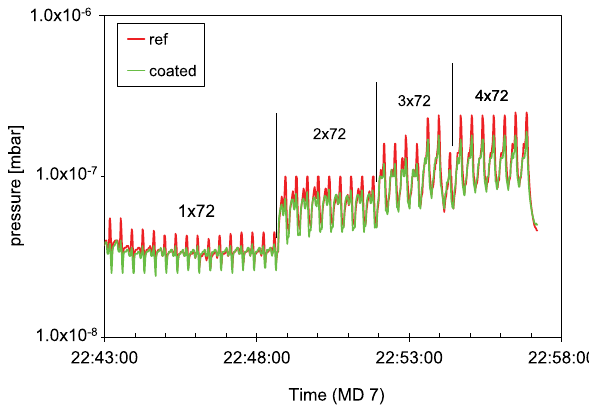
FIG. 13. Inspection of four a-C liners extracted from the SPS. (a) C-stripe, a-C coating used for confirming the minimum of coating width. (b) C = Zr , a-C on rough Zr coating. (c) C-Ne3. (d)